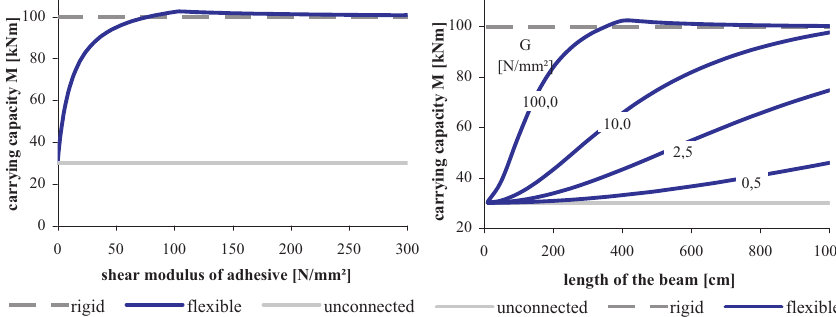
Figure 4 a and b: influence of beam length and adhesive stiffness on carrying